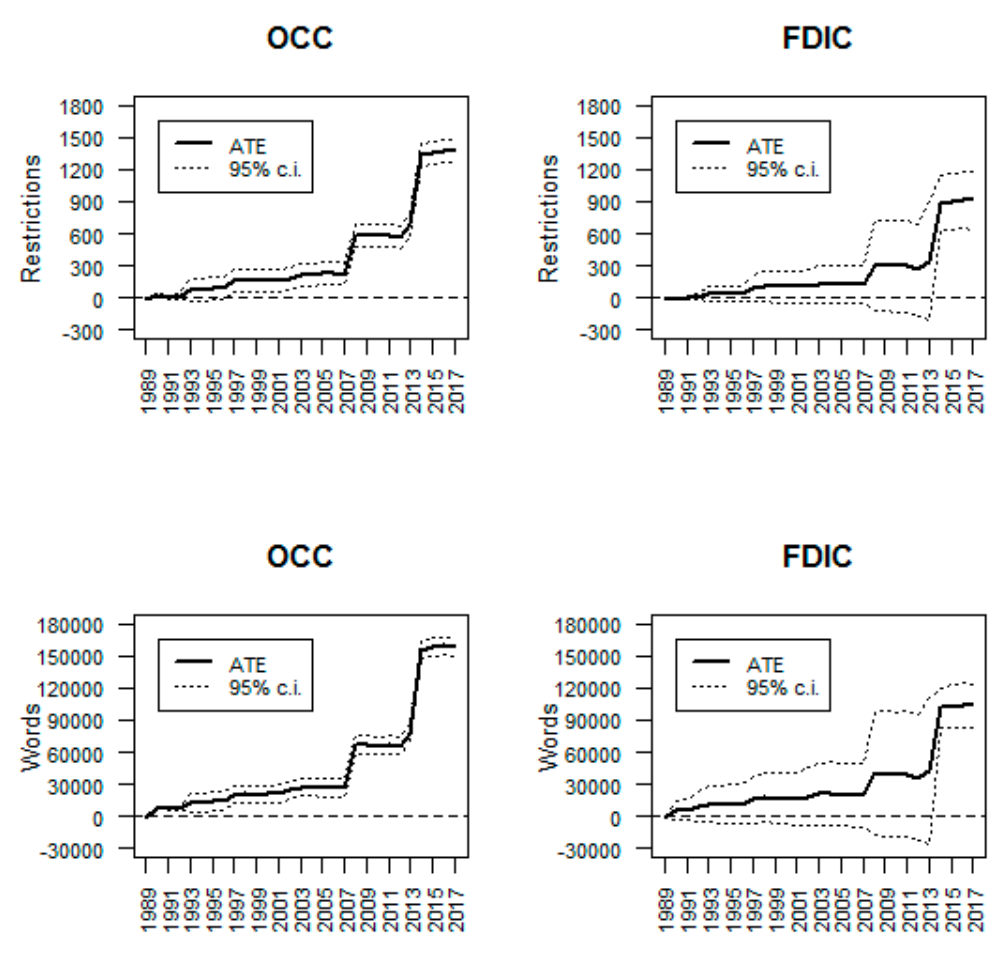
Figure 2. Average Treatment Effects of Bank Capital Requirements on Regulatory Restrictions and Word Counts Since Basel I, 1989–2017.